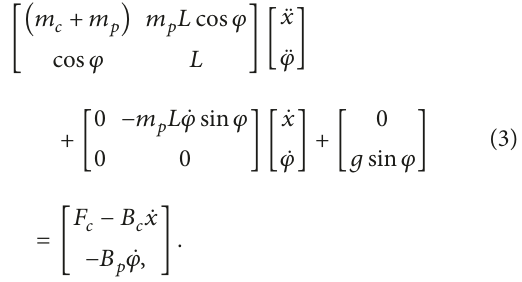
Figure 1: System schematicdiagram. The motor is assumed stopped and the payload was at an angle. Table 1: Dynamics model